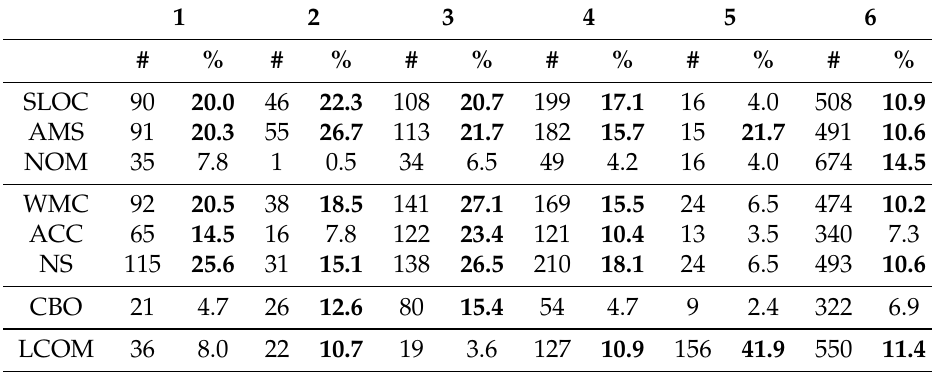
Table 4. Number of potentially deficient classes within Notepad++ (1); Money Manager (2); 7-Zip (3); TortoiseSVN (4); FileZilla (5) and MySQL Server (6) identified by using each software metric separately.